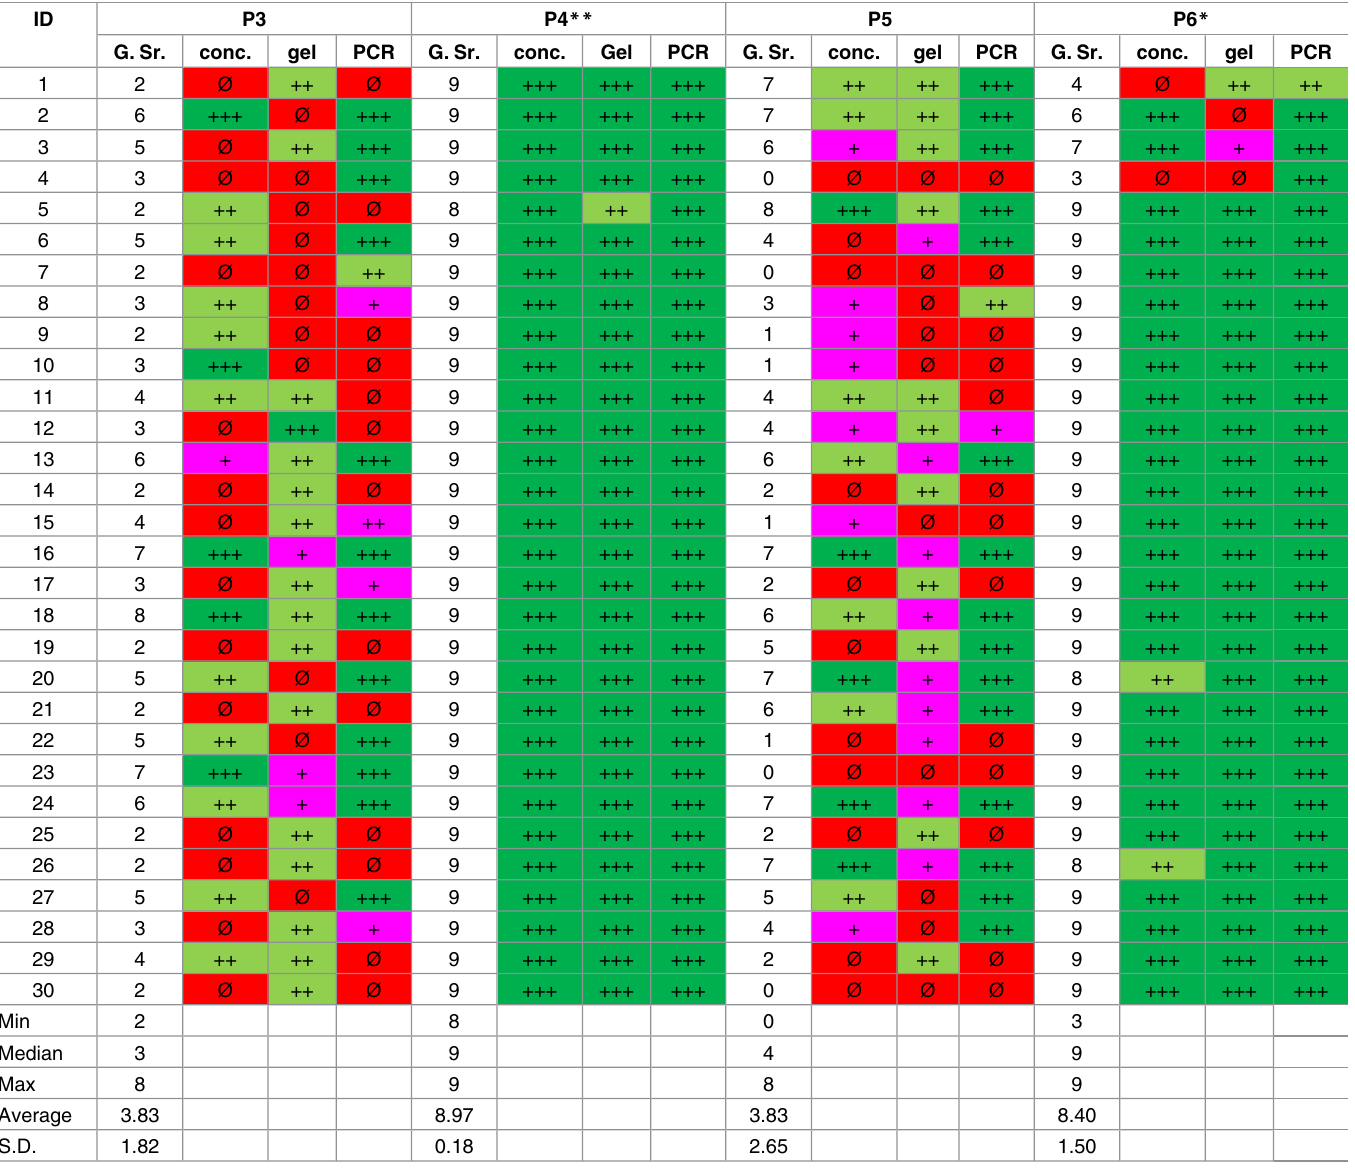
Table 6. DNA concentration, agarose gel electrophoresis and multiplex PCR, micro-satellite typing and cattle parentage determination. ID P3 P4 ** P5 G.